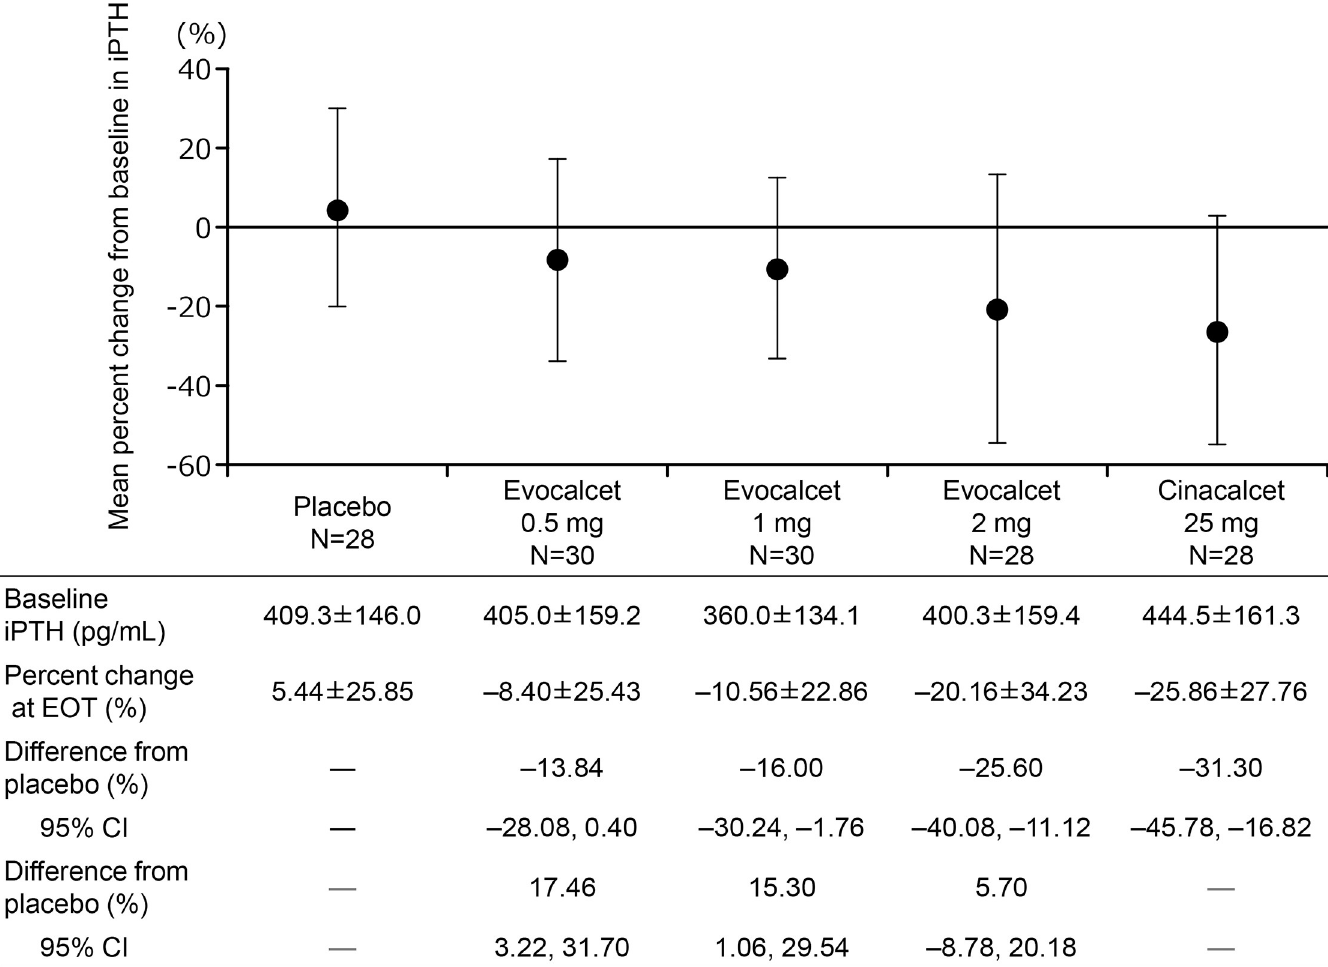
Fig 3. Point estimate of percent changes in iPTH at EOT. The error bars indicate standard deviation. iPTH, intact parathyroid hormone; EOT, end of treatment; CI, confidence interval.